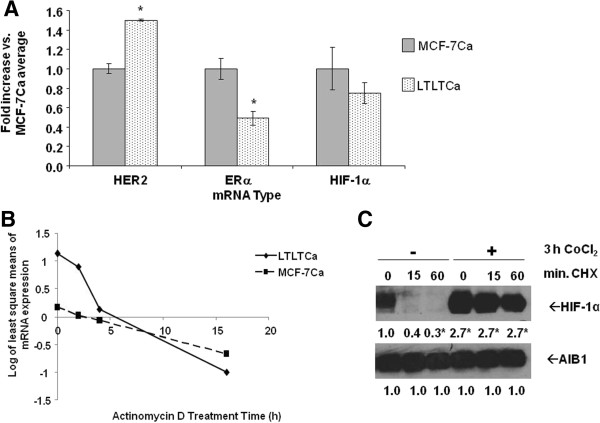
Comparison of HIF-1α mRNA expression and stability in LTLTCa and MCF-7Ca cells. A) LTLTCa and MCF-7Ca cells were plated and cultured in their respective passage media under normal cell culture (nonhypoxic) conditions. Total RNA was extracted and HER2, ERα, HIF-1α and 18S rRNA were analyzed by real-time RT-PCR analysis. Results shown are expressed as the mean fold-change in mRNA levels compared with MCF-7Ca cells after normalization to 18S rRNA (mean ± SD of n = 6 independent cell samples/group; *versus MCF-7Ca; effect of gene type P <0.0001, effect of cell type P = 0.1376, interaction between gene type and cell type P <0.0001; *MCF-7Ca versus LTLTCa for specific gene, P <0.0001; two-way ANOVA). B) LTLTCa and MCF-7Ca cells were treated with vehicle or 0.5 μg/ml actinomycin D for 0 to 16 hours. Total RNA was extracted and HIF-1α mRNA underwent real-time RT-PCR. Results are expressed as least square means of log transformed averages of mRNA expression at various timepoints (trend over time) after normalization to corresponding vehicle-treated samples and analysis by linear mixed effect model, adjusting for experiment, cell line and cell line*time interaction (means ± SD of n = 6 independent samples/group; P <0.001 for effect of cell line, time, their interaction and experiment). C) LTLTCa cells were treated with vehicle or 100 μM CoCl2 for three hours and then with 100 uM cycloheximide for 0 to 60 minutes. Whole cell protein was extracted and underwent Western blot for HIF-1α and AIB1 protein. Shown are representative blots and overall densitometry results of n = 6 independent cell samples/group. Densitometry results are expressed as mean fold-change in protein levels compared to vehicle-treated-0 minutes cycloheximide cells after normalization to AIB1 (mean ± SD of n = 6 independent cell samples/group; *versus no CoCl2-0 minutes CHX, P <0.0001, one-way ANOVA). ANOVA, analysis of variance; ERα, estrogen receptor alpha; HER2, human epidermal growth factor receptor 2; HIF-1α, hypoxia inducible factor 1 α subunit; n, number; SD, standard deviation.